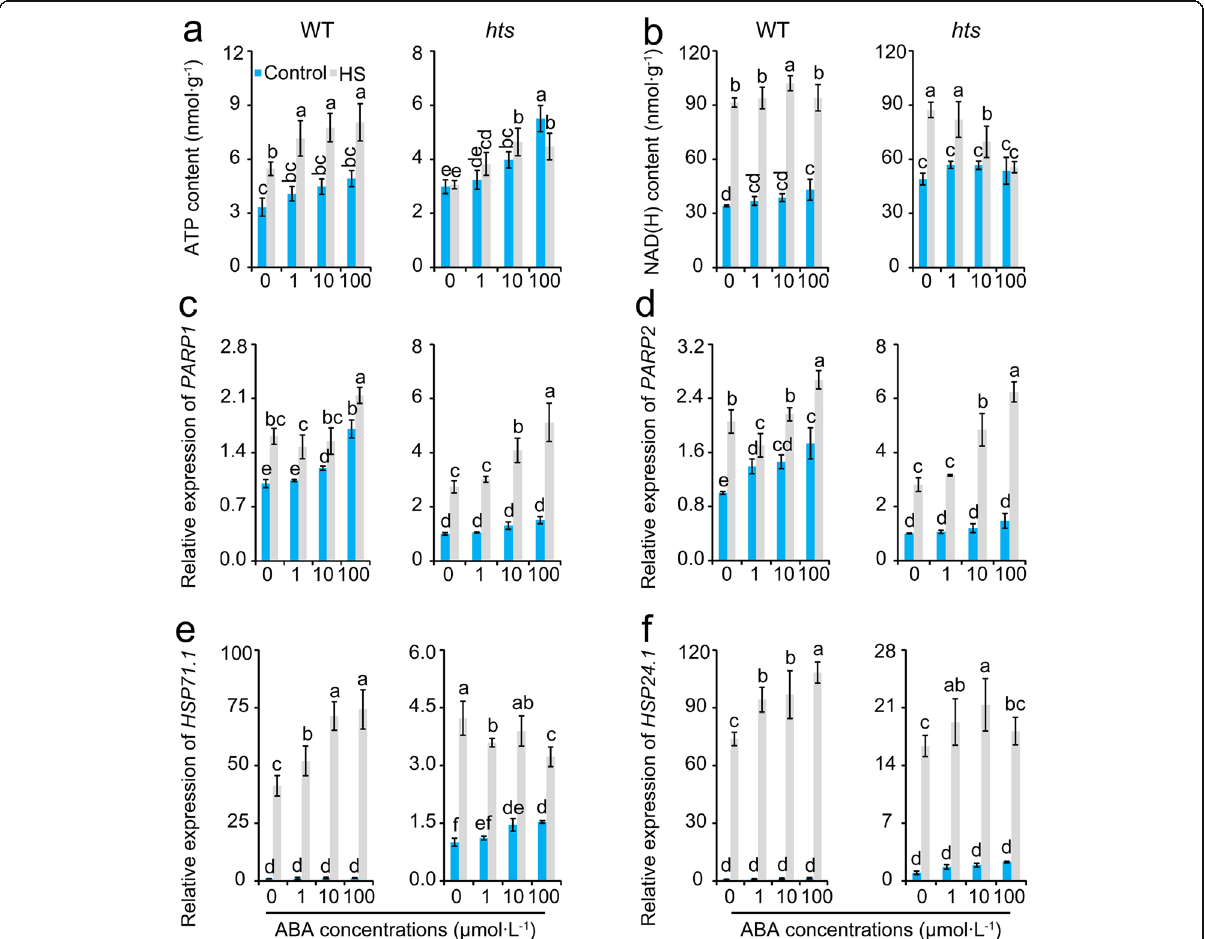
Fig. 8 Changes in ATP and NAD (H) contents as well as the expression levels of HSP genes in leaves of rice plants in response to ABA under heat stress. a , ATP content; b , NAD (H) content; c , Relative expression level of PARP1 ; d , Relative expression level of PARP2 ; e , Relative expression level of HSP71.1 ; f , Relative expression level of HSP24.1 . Vertical bars denote standard deviations ( n = 3). Different letters indicate a significant difference among the ABA treatments under the control and heat-stressed conditions within a genotype by two-way analysis of variance for two factors (temperature and treatment) ( P <